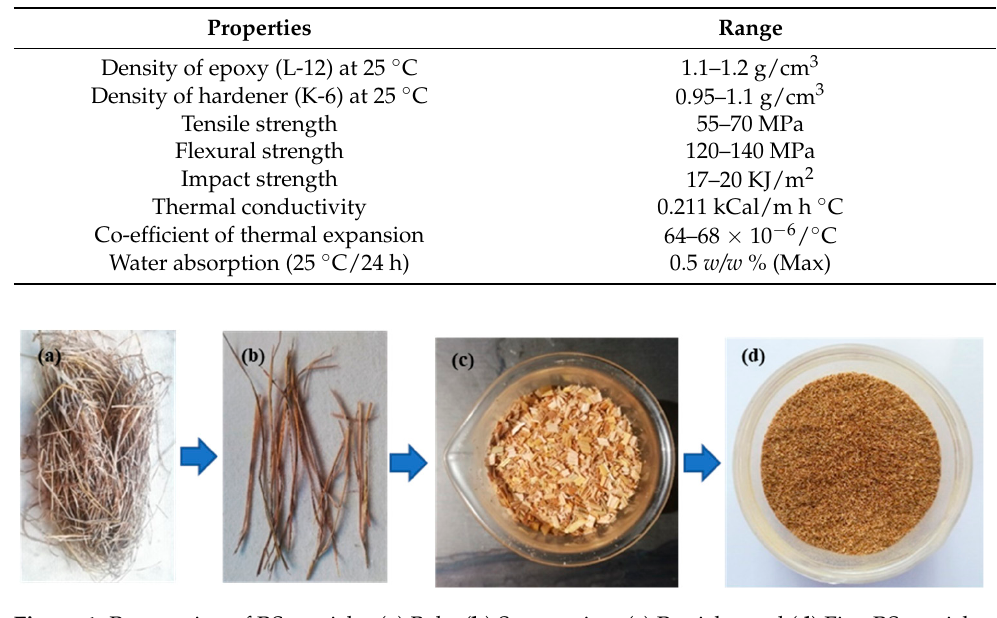
Table 1. Properties of epoxy (As specified by the supplier).